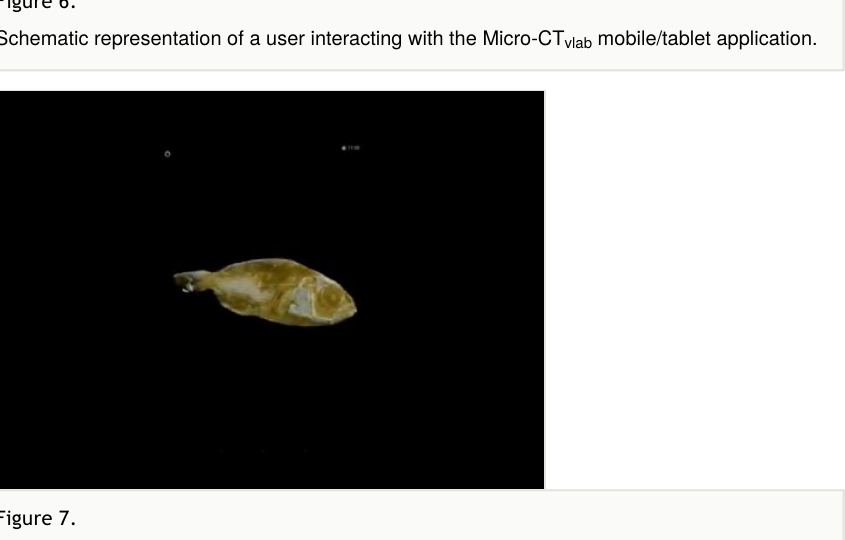
Figure 7. Screencast demonstrating the features of the Micro-CT